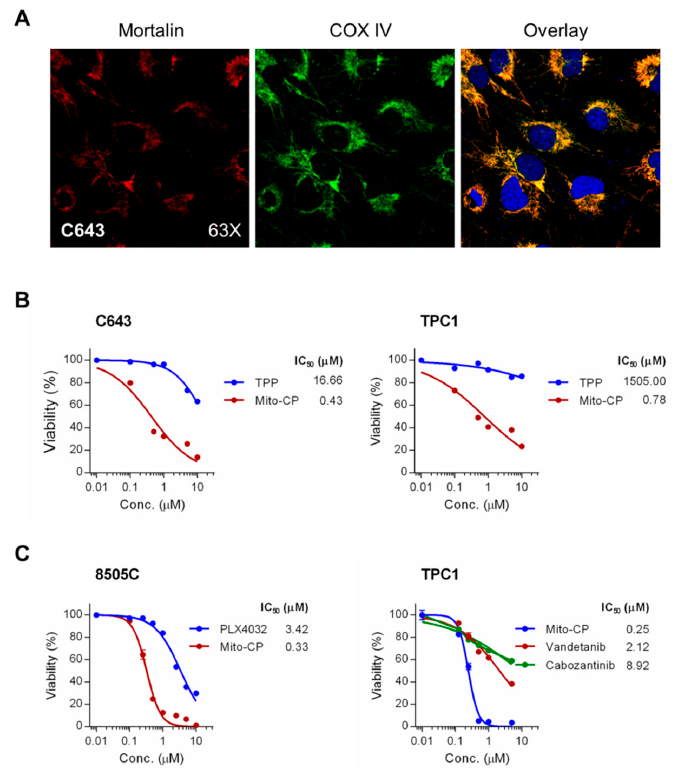
Figure 6. Mito-CP suppresses viability of PTC and ATC cells. ( A ) Immunofluoresence analysis of mortalin localization in C643 cells. cytochrome c oxidase (COX IV) serves as a marker specific to mitochondria. Areas of overlap are seen as yellow. ( B ) C643 and TPC-1 cells in 96-well plates were treated with serially increasing doses of Mito-CP or the control compounds, TPP, for 48 h. Cells were then allowed to recover in drug-free fresh medium for 24 h prior to measuring cell viability by 3-(4,5-dimethyl-2-thiazolyl)-2,5-diphenyltetrazolium bromide (MTT) assay. Data (mean ± SD, n = 4) are expressed as the percentage of untreated control. ( C ) Cells of 8505C and TPC-1 were treated with increasing doses of Mito-CP, PLX4032, vandetanib, or cabozantinib for 48 h. Cells were then allowed to recover in drug-free fresh medium for 24 h prior to MTT assay. As determined by a 3-(4,5-dimethyl-2-thiazolyl)-2,5-diphenyltetrazolium bromide (MTT) assay, Mito-CP in 0.01–10 μ M dose ranges effectively decreased cell viability of C643, TPC-1, and 8505C cells within 48 h, with all cell lines exhibiting very high sensitivity to this drug (Figure 6B,C); IC 50 values were calculated at 0.43 μ M for C643, 0.78 μ M for TPC-1, and 0.33 μ M for 8505C. Mito-CP consists of the CP moiety, a 5-membered nitroxide that has antioxidant properties, and the TPP moiety that mediates mitochondria targeting – the chemical structure of Mito-CP is depicted in Figure S2 of ref [18]. In contrast to Mito-CP, equal doses of TPP did not significantly decrease cell viability of these cells, as determined with C643 and TPC-1 cells, indicating the specificity of Mito-CP (Figure 6B). We also assessed Mito-CP for its efficacy relative to the FDA-approved kinase inhibitors. As determined by MTT assay after 48 h drug treatments (Figure 6C), Mito-CP was about 10 times more potent than the B-Raf inhibitor PLX4032 in 8505C cells (IC 50 values 0.33 μ M vs 3.42 μ M) and also far more potent than the tyrosine kinase inhibitors, vandetanib and cabozantinib, in TPC-1 cells (IC 50 values 0.25 μ M vs 2.12 μ M and 8.92 μ M). To determine the nature of Mito-CP-mediated suppression of these tumor cells, we conducted Western blot analyses of total lysates of C643 and TPC-1 cells treated with Mito-CP for 48 h. Consistent with its mitochondria damaging effects, Mito-CP decreased COX IV levels in both cell lines in a dose-dependent manner (Figure 6A). Under these conditions, we found that Mito-CP